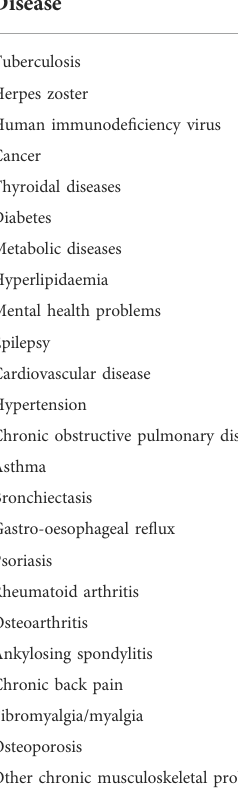
TABLE 1 Chronic medical diseases/conditions according to ICD-10 considered relevant in this